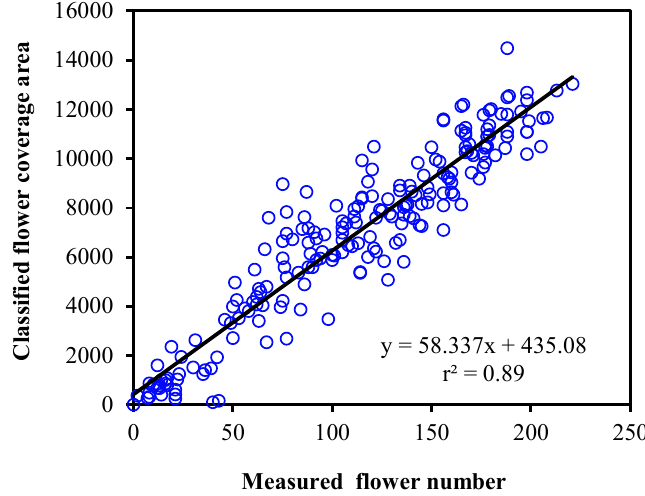
Figure 4. The relationships between measured flower number and classified flower coverage area (FCA) on 21 March 2017at Zhuji and 28 March 2018 at Hangzhou. The result was conducted by the K-means algorithm based on Commission Internationale de l’ É clairage (CIE) L*a*b* space. ( n = 209).